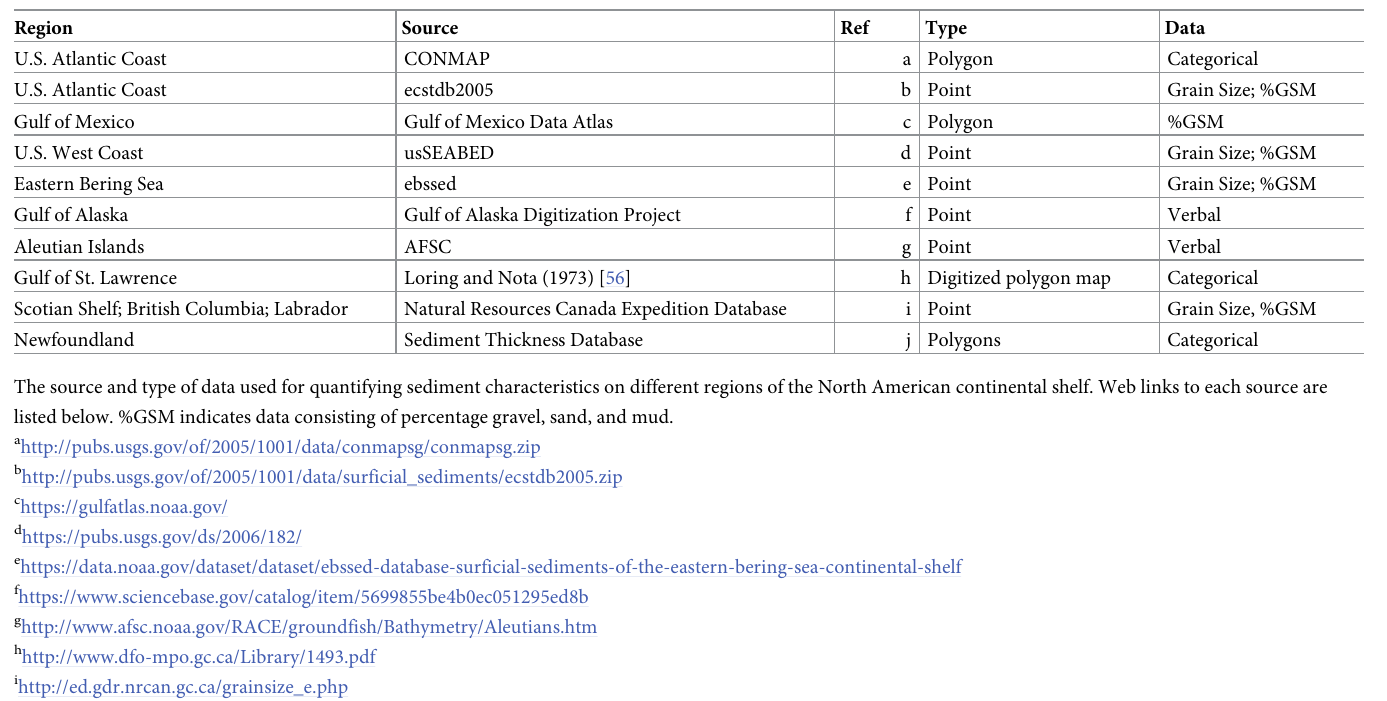
Table 2. Sediment data